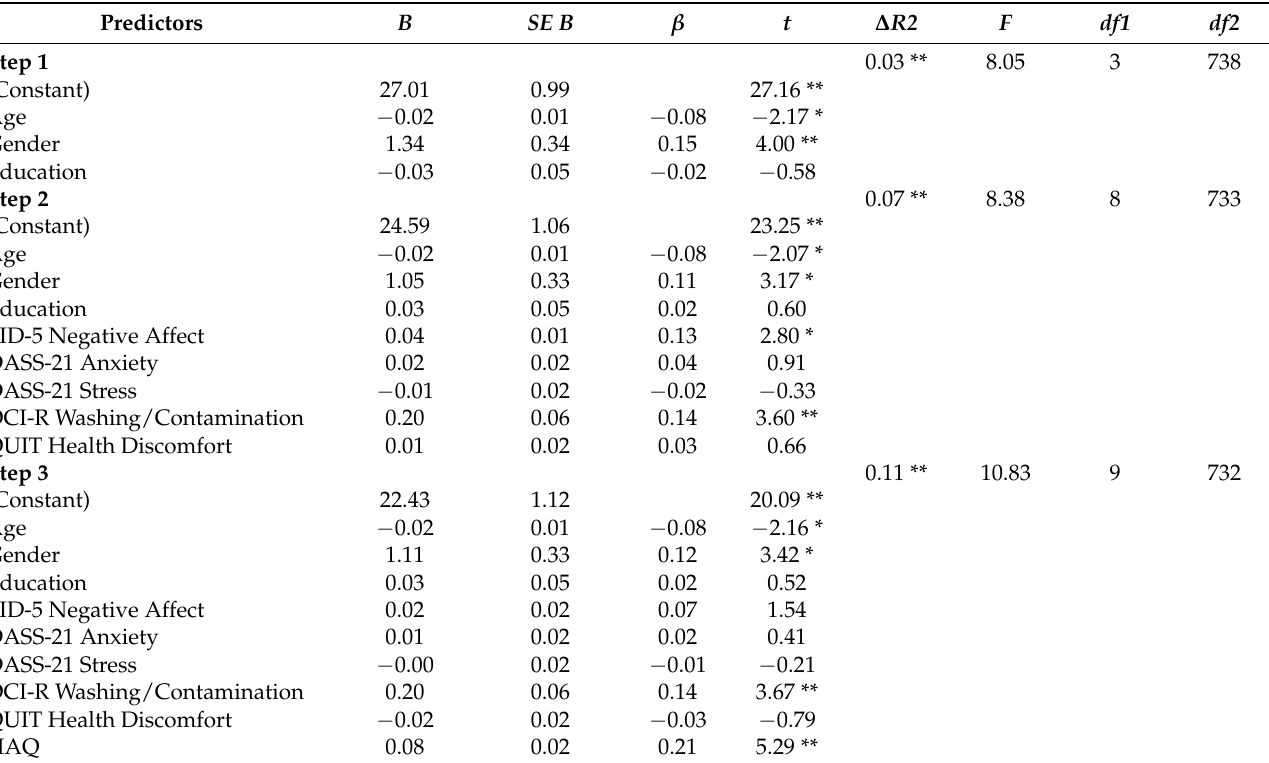
Table 2. Results of linear regression analysis predicting Perceived Dangerousness of Infection Questionnaire